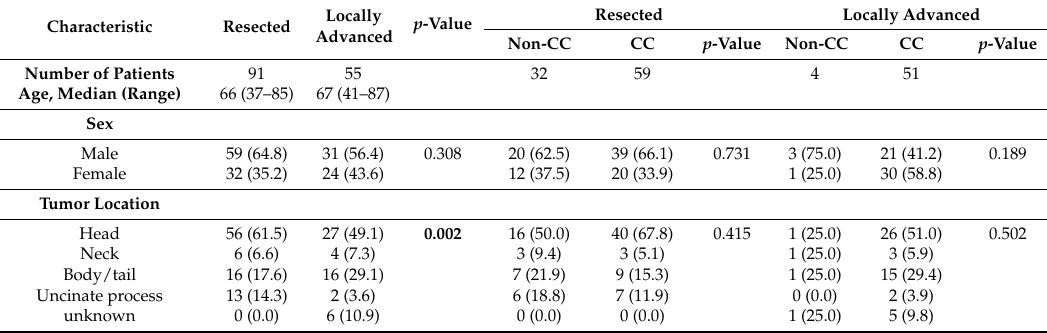
Figure 2. Kaplan–Meier curves of overall survival (OS) ( A ) and disease-free survival (DFS) ( B ) in relation to CC status at diagnosis among patients with pancreatic cancer (PC). CC, positive cancer cachexia status; Non-CC, negative cancer cachexia status. Table 1. Clinical characteristics of PC patients with or without CC.